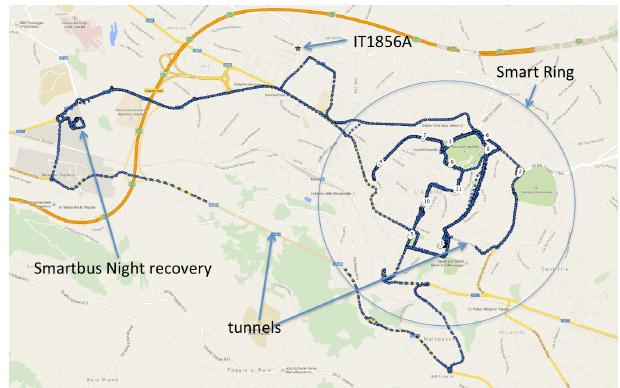
Figure 2. The Smart Ring area and the reference monitoring station IT1856A as indicated in European databases [35]. The blue circles represent the SmartBus positions during the campaign. The white circles with numbers indicate the majorly frequented SmartBus stops along the Smart